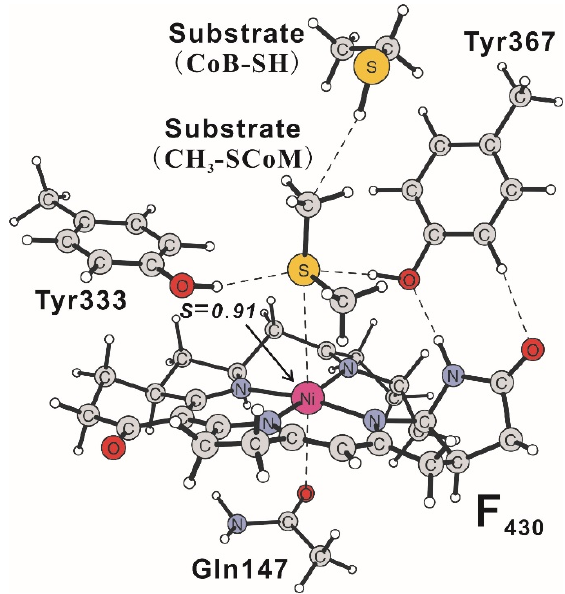
Figure 6. Model used in the calculations of the methyl-coenzyme M reductase (MCR). Adapted from [74], copyright © WILEY-VCH Verlag GmbH & Co. KGaA, Weinheim.